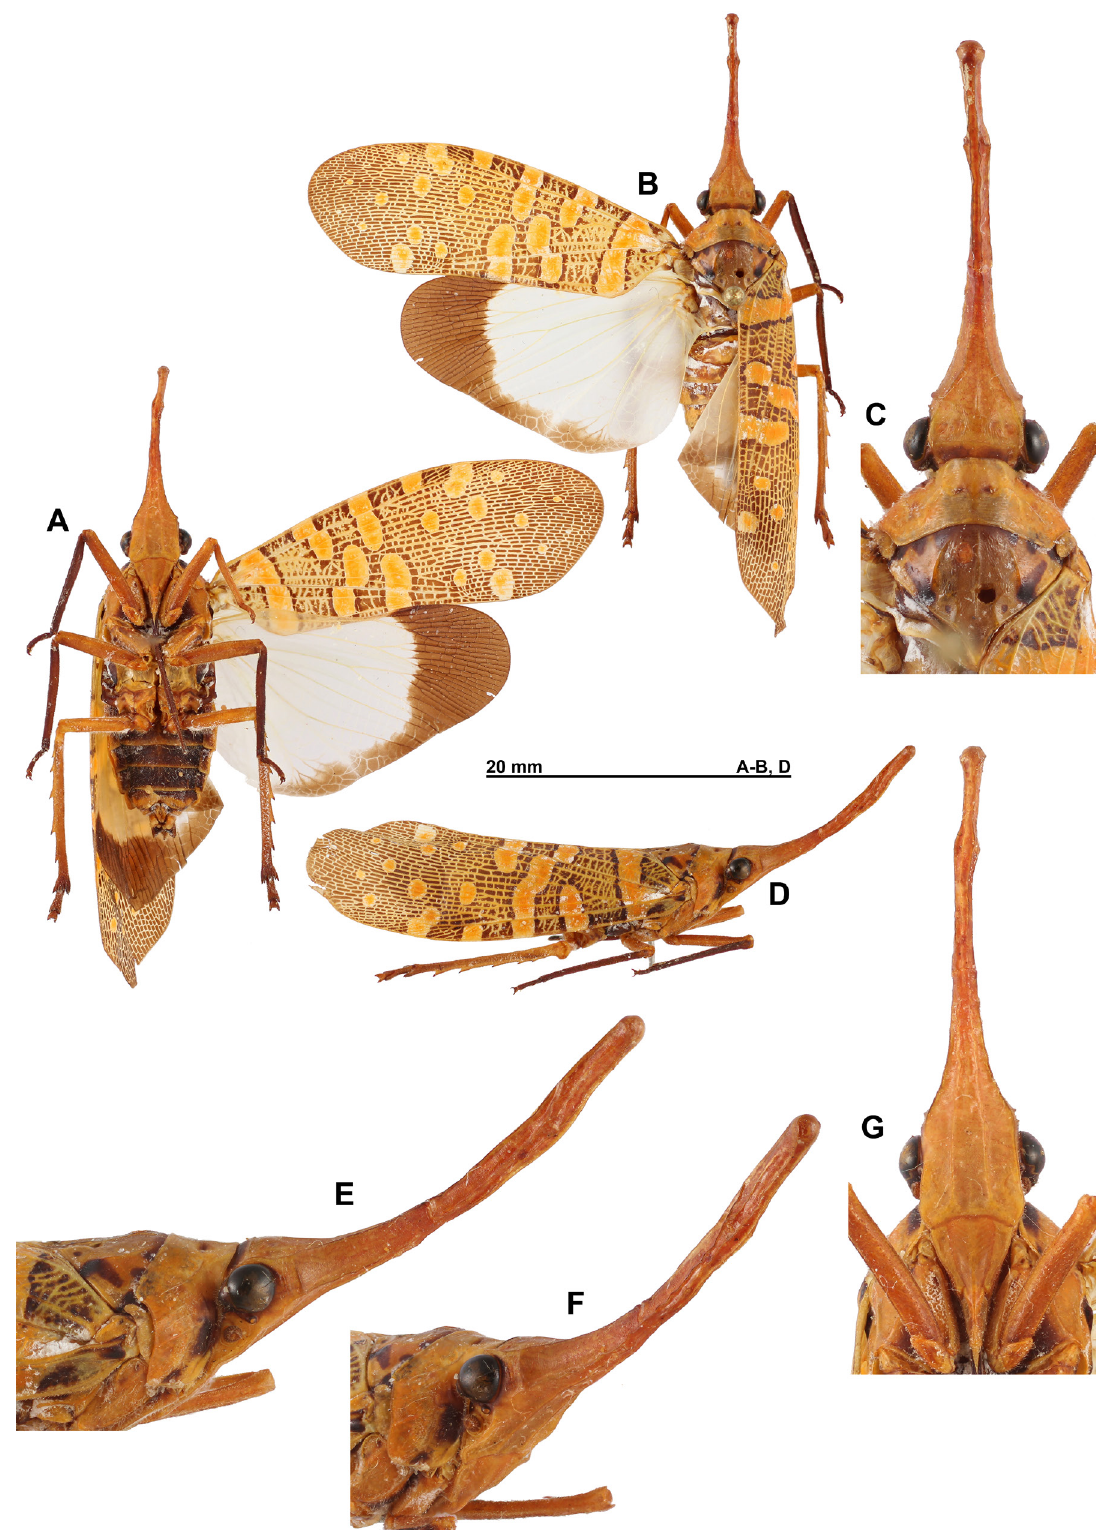
Fig. 1. Pyrops buomvoi sp. nov., paratype ♀ (RBINS). A . Habitus, ventral view. B . Habitus, dorsal view. C . Head and thorax, dorsal view. D . Habitus, lateral view. E . Head and thorax, lateral view. F . Head and thorax, anterolateral view. G . Head, perpendicular view of frons. C, E–G = not to